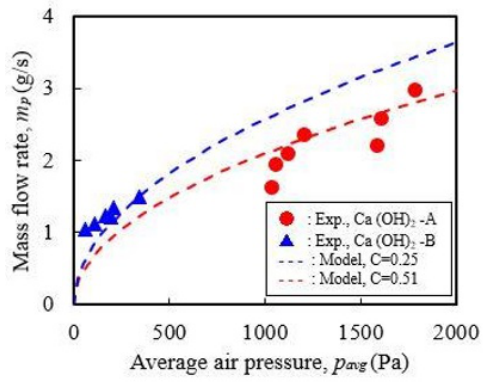
Fig. 3. Relationship between the mass flow rate and the average air pressure at the top of the powder bed